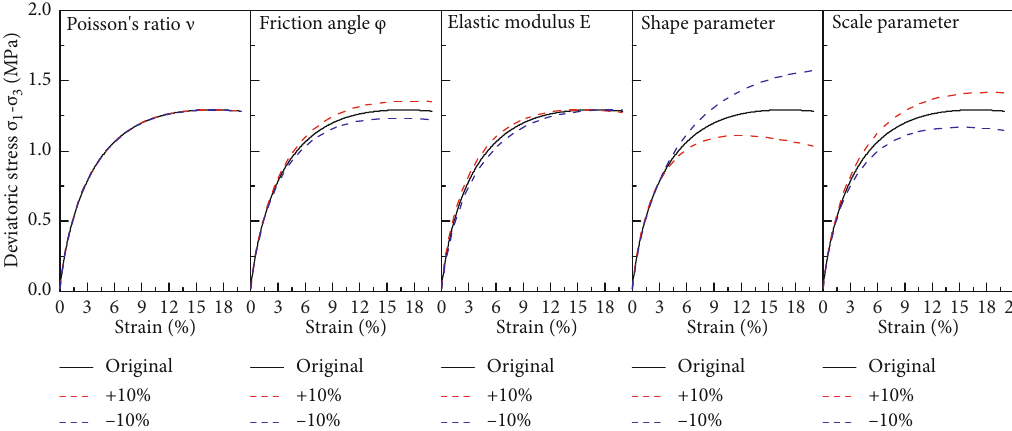
Figure 10: Comparison of the in fl uence of a 10% increase and 10% decrease in each parameter of the model on the calculation curve (frozen silty clay).